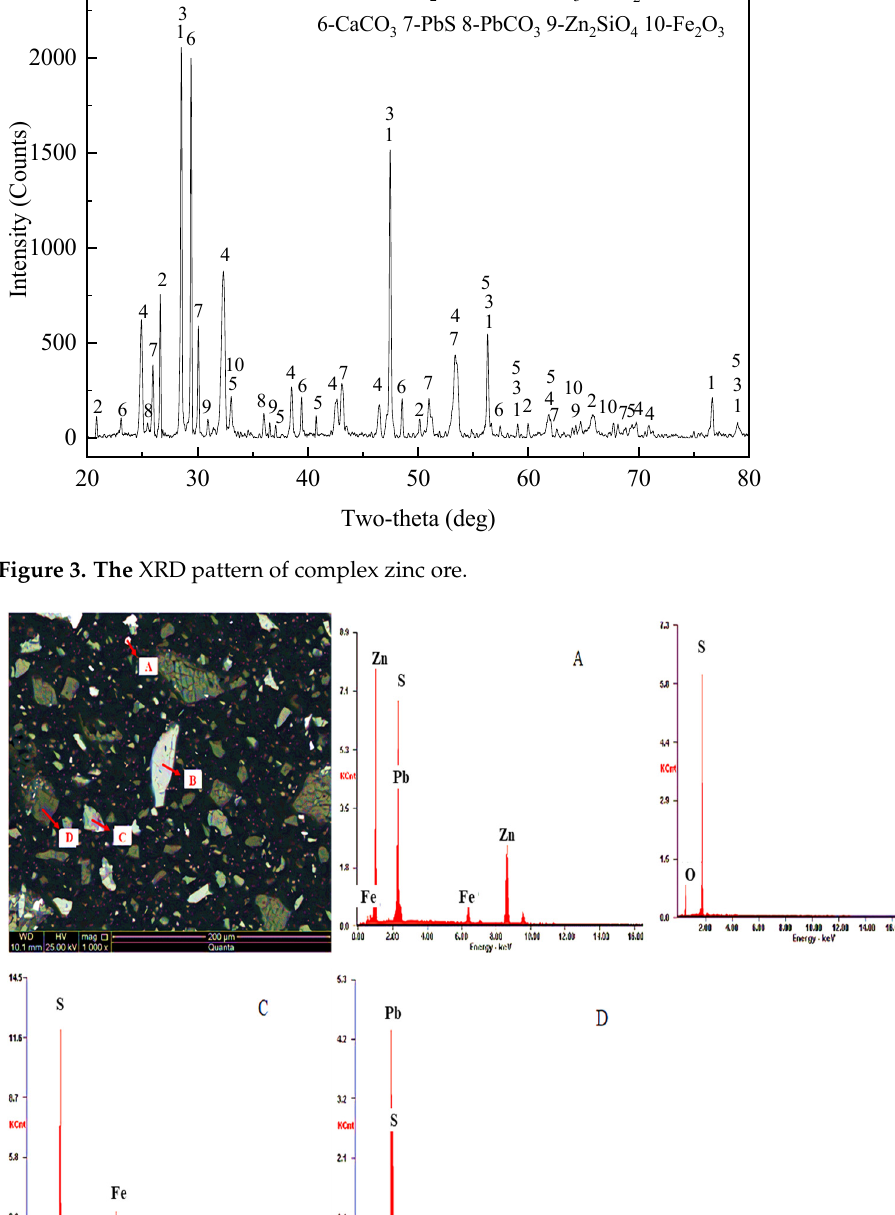
Figure 3. The XRD pattern of complex zinc ore.